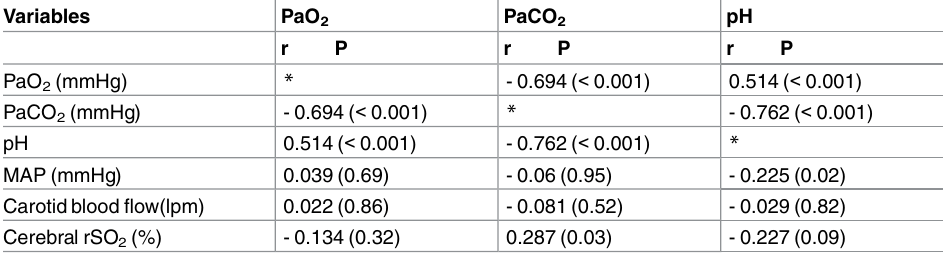
Table 4. Correlation between gasometrical values and MAP, carotidbloodflow and cerebralrSO 2 .